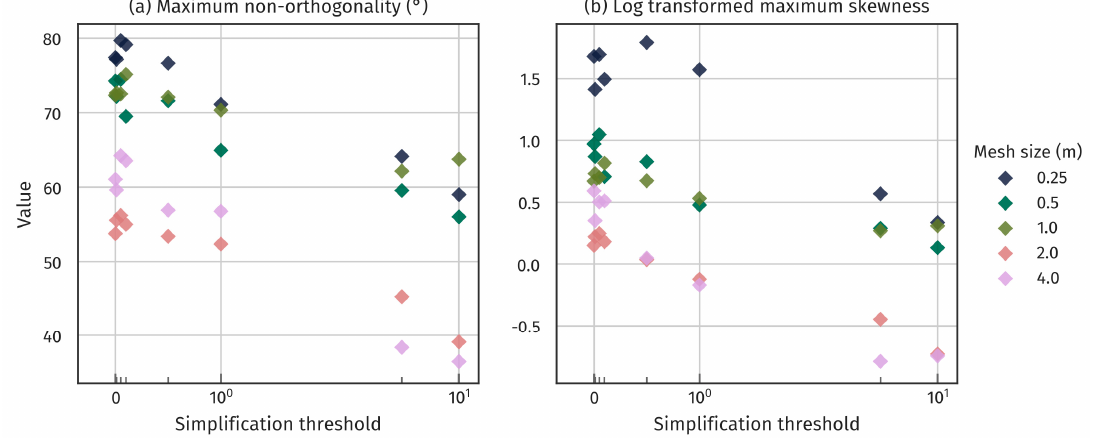
Table 3. Regression analysis of hexahedron cell